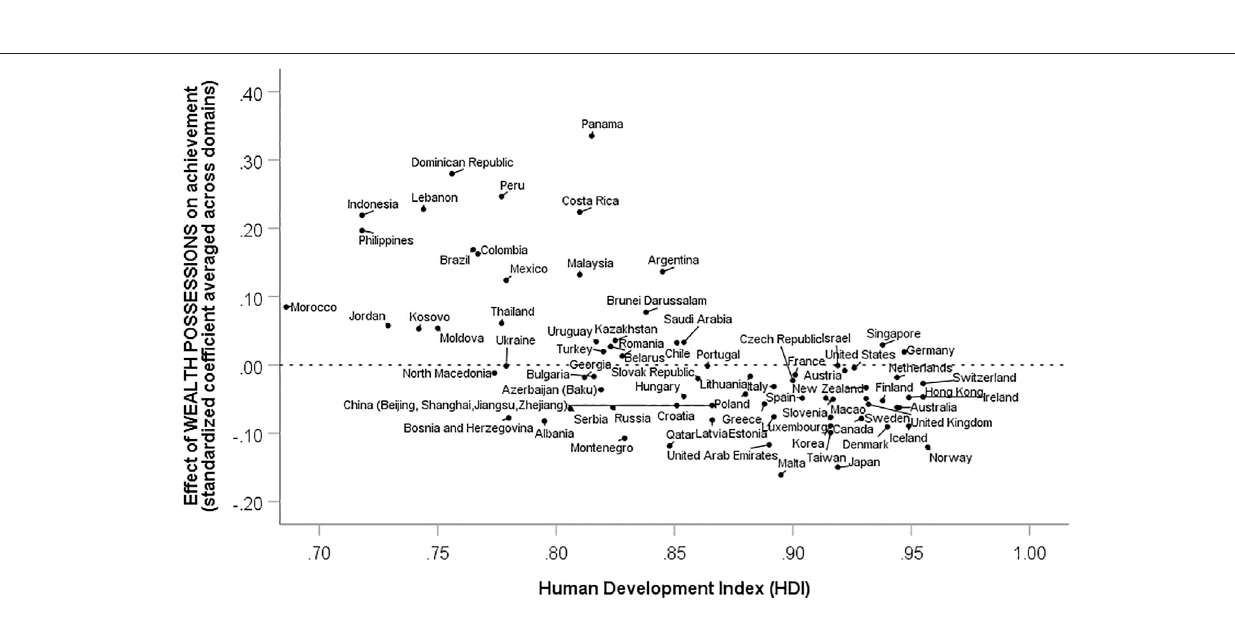
Frontiers in Education |